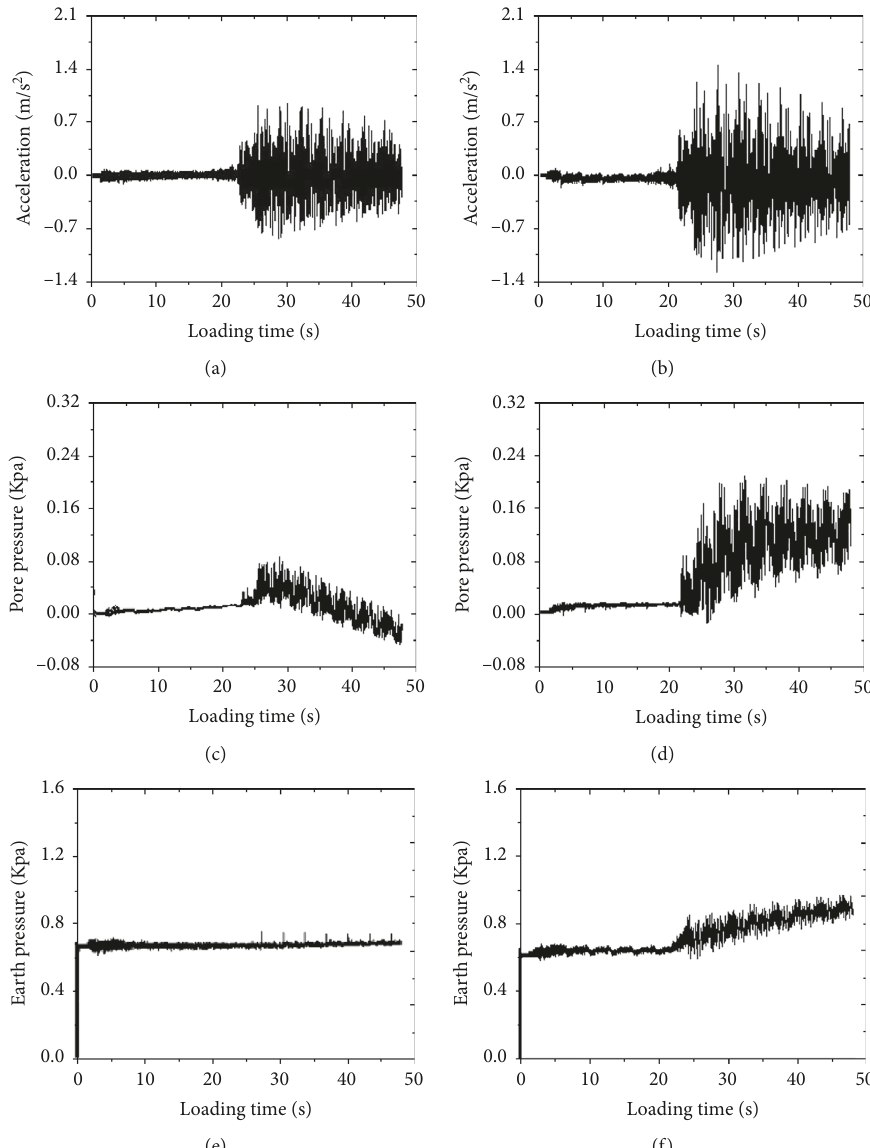
Figure 10: Time history of acceleration, pore pressure, and earth pressure on the slope shoulder.